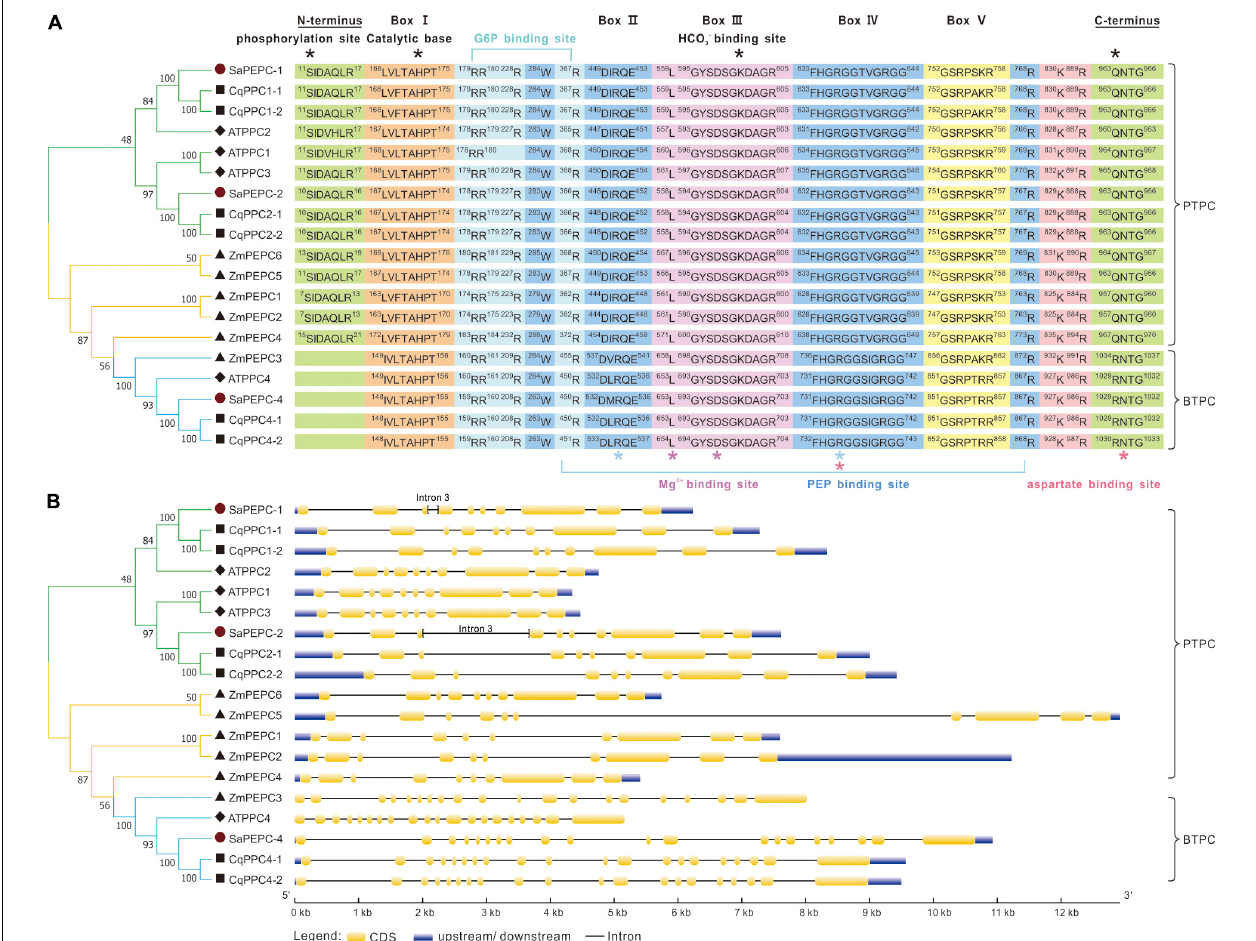
FIGURE 2 | Sequence alignment (A) and gene structure analysis (B) of PEPCs among S. aralocaspica , A. thaliana , C. quinoa , and Z. mays . Box I–V are conserved sequences responsible for the activity of PEPC enzyme. *: Indicates the key domains of the catalytic reaction and binding sites for the substrate and